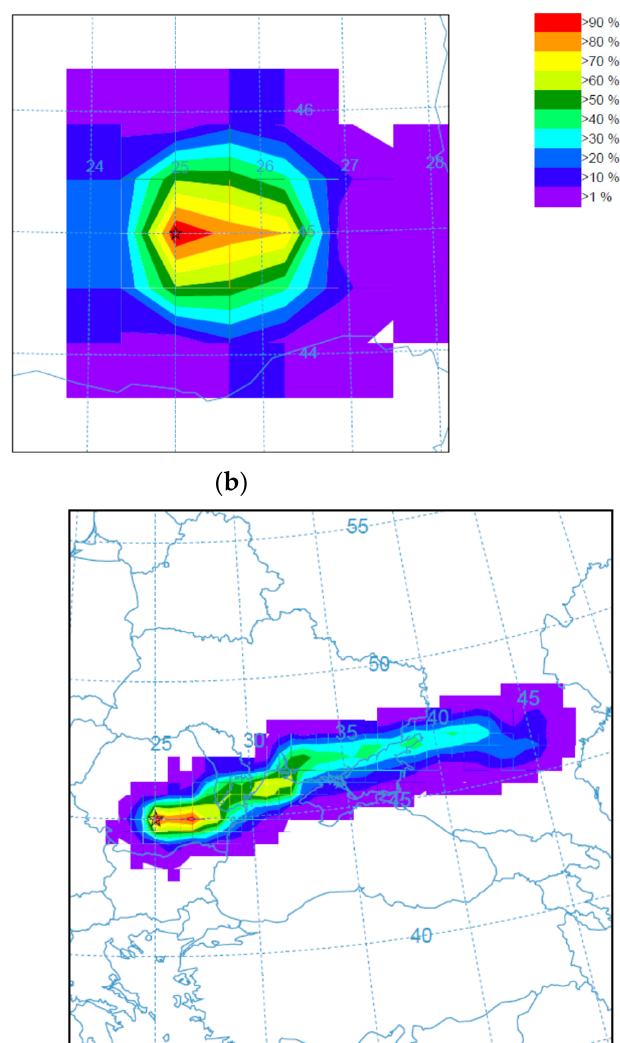
to 26 November ber to 26 November 2019.